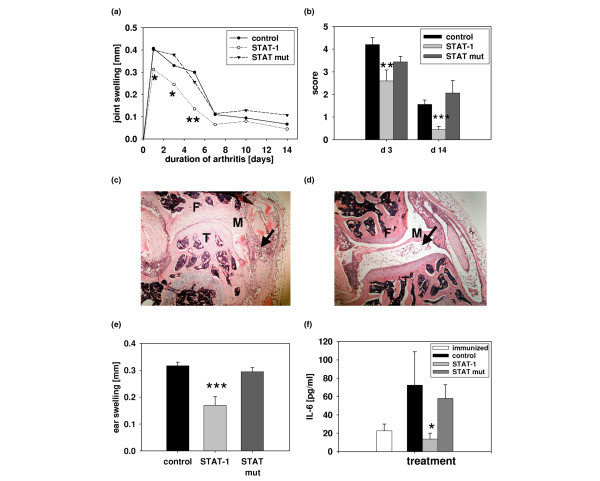
Specificity of the STAT-1 decoy oligodeoxynucleotide (ODN) treatment on the acute and chronic phase of antigen-induced arthritis (AIA). Arthritis was induced in the right knee joint at day 0, 4 h after application of the ODN. (a) Joint swelling after treatment with STAT-1 decoy ODN (STAT-1) and mutant control ODN (STAT mut) (all ODNs 0.25 nmol per knee; n = 8 to 10) in comparison to buffer-treated mice with AIA (control, n = 8 to 10). Joint swelling was assessed as the difference between right (arthritic) and left (untreated) knee joint diameter. (b) Total arthritis score after histological evaluation. Hematoxylin-eosin (HE) stained knee sections were evaluated blindly by grading of inflammation (cell exudate or infiltrate, hyperplasia) and joint destruction (necrosis, erosion and pannus formation). Total arthritis score is defined as the sum of the inflammation and destruction scores. Effects of STAT-1 decoy ODN (STAT-1) in comparison to mutant control ODN (STAT mut) (all ODNs 0.25 nmol per knee joint) on the acute phase (3 days after arthritis induction, d 3; n = 8 to 10) or on the chronic phase of AIA (14 days after arthritis induction, d 14; n = 8 to 10). (c,d) HE-stained sections of arthritic joints 3 days after arthritis induction. Knee joints of STAT-1 decoy ODN-treated mice (d) were less inflamed than joints of buffer-treated control animals (c) (see arrows). F, femur; T, tibia; M, meniscus. (e) Delayed-type hypersensitivity (DTH) reaction on day 7 after arthritis induction. Swelling was expressed as the difference (mm) between the ear thickness before and after antigen injection. The DTH reaction was also diminished in STAT-1 decoy ODN-treated mice, suggesting the involvement of STAT-dependent Tcell activation, whereas the STAT mutant ODN did not display such an effect (f) Effects on the serum levels of IL-6 at day 3 of AIA mice treated with the STAT-1 decoy ODN (STAT-1) or the STAT mutant ODN (STAT mut) (n = 8 to 10). Serum from immunized mice (day 0) served as reference. *P ≤ 0.05, **P ≤ 0.01, ***P ≤ 0.001 versus buffer-treated AIA control.